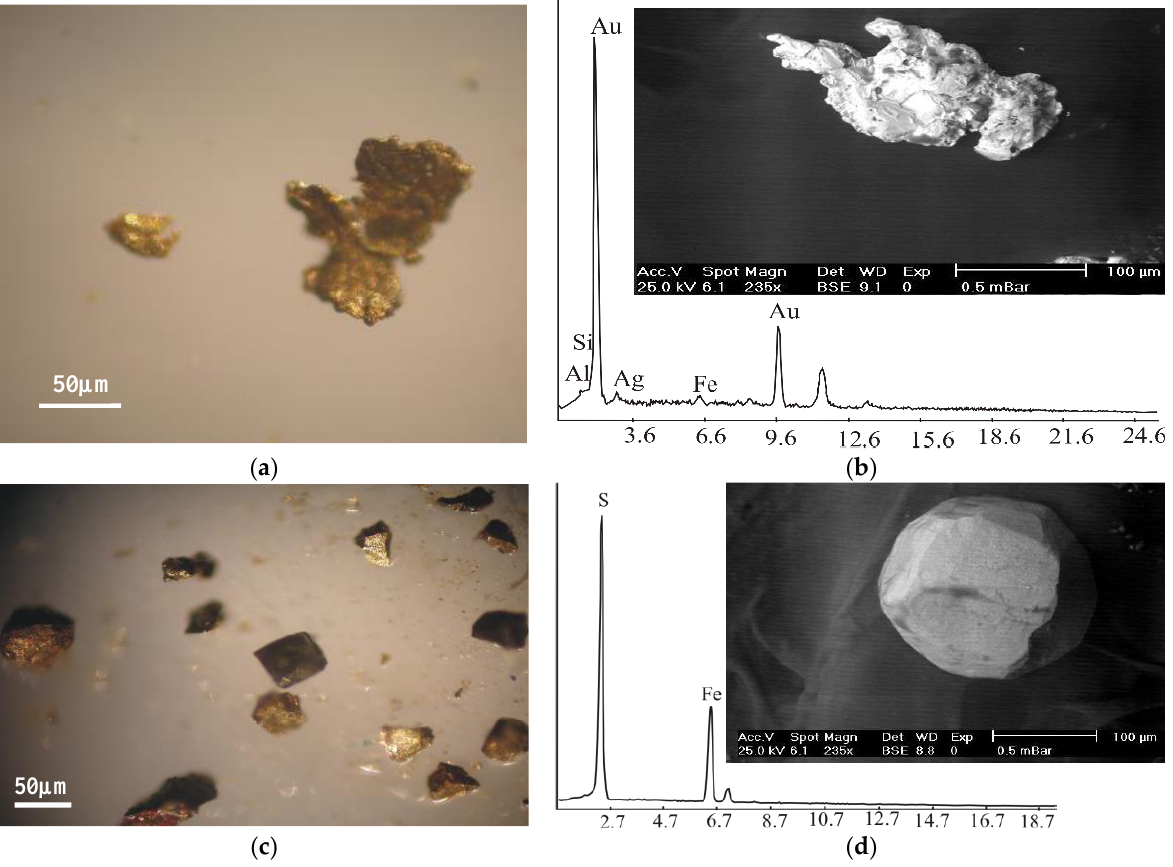
Figure 7. Gold and pyrite mineralization from quartz veins in south Monqul, north Eastern Desert, Egypt. ( a ) Photomicrograph showing yellowish grains of gold under binocular microscope; ( b ) BSE images and EDS chart for gold; ( c ) photomicrograph showing brownish grains of pyrite under binocular microscope; and ( d ) BSE images and EDS chart for pyrite.